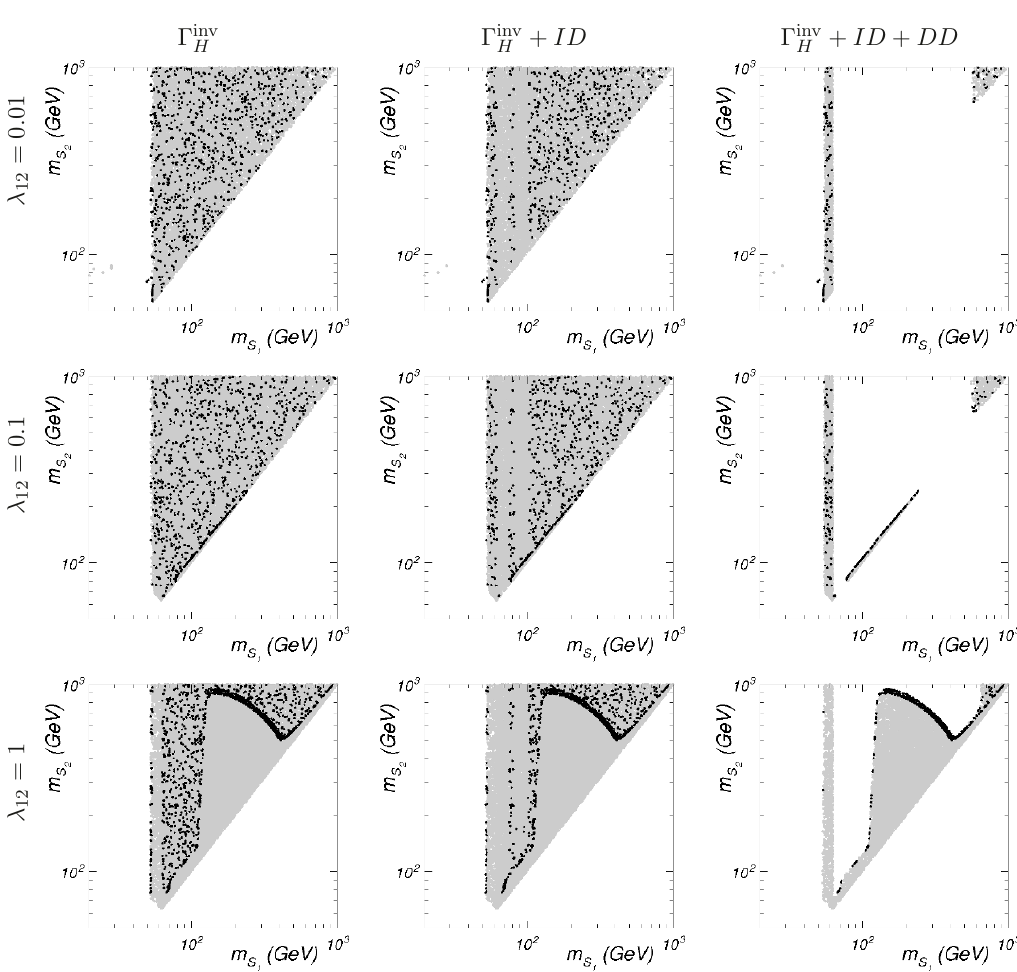
m S , m S parameter space of the ESHP 1 2 } {